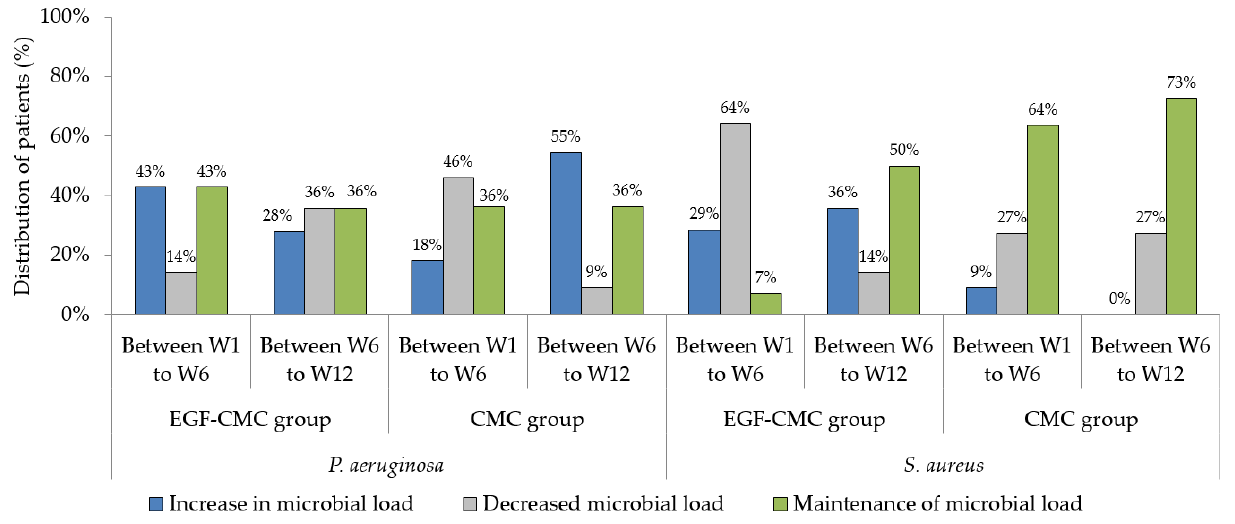
Figure 1. Distribution of patients according to bacterial load (using qPCR). Abbreviations: W1, Week 1; W6, Week 6; W12, Week 12.